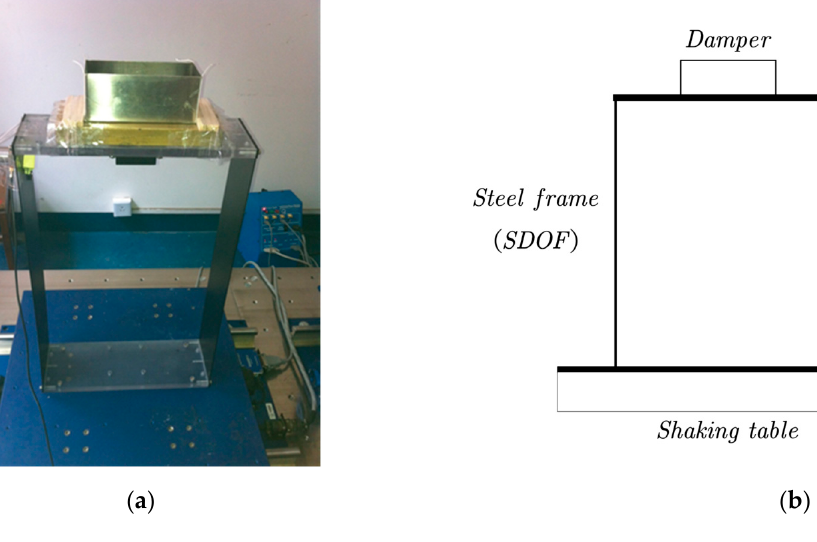
Figure 3. Steel frame model. ( a ) Experimental model; ( b ) schematic diagram of the experiment. Table 1. Dynamic characteristics of frame (without mass block).